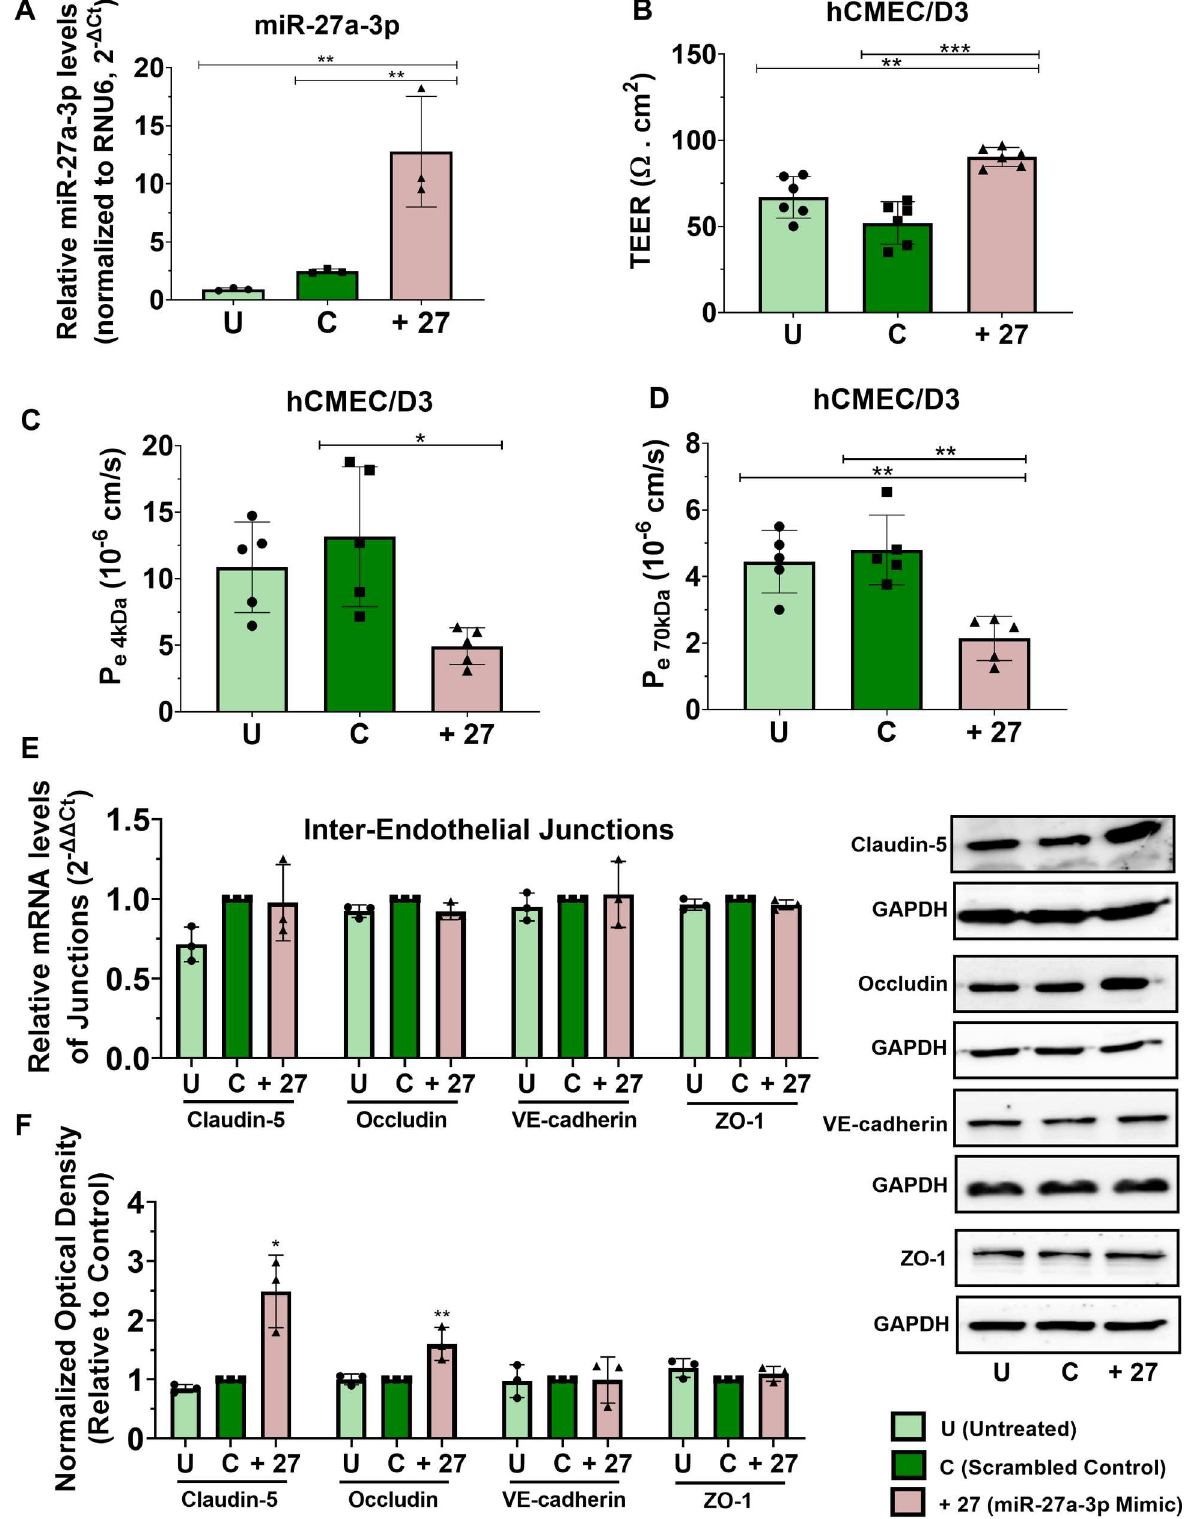
Fig 2. miR-27a-3p mimic reduces the brain endothelial barrier permeability and upregulates claudin-5 and occludin protein expression. hCMEC/D3 cells were transfected with miR-27a-3p mimic or control for 72h. (A) miR-27a-3p relative expression measured by real-time PCR. The